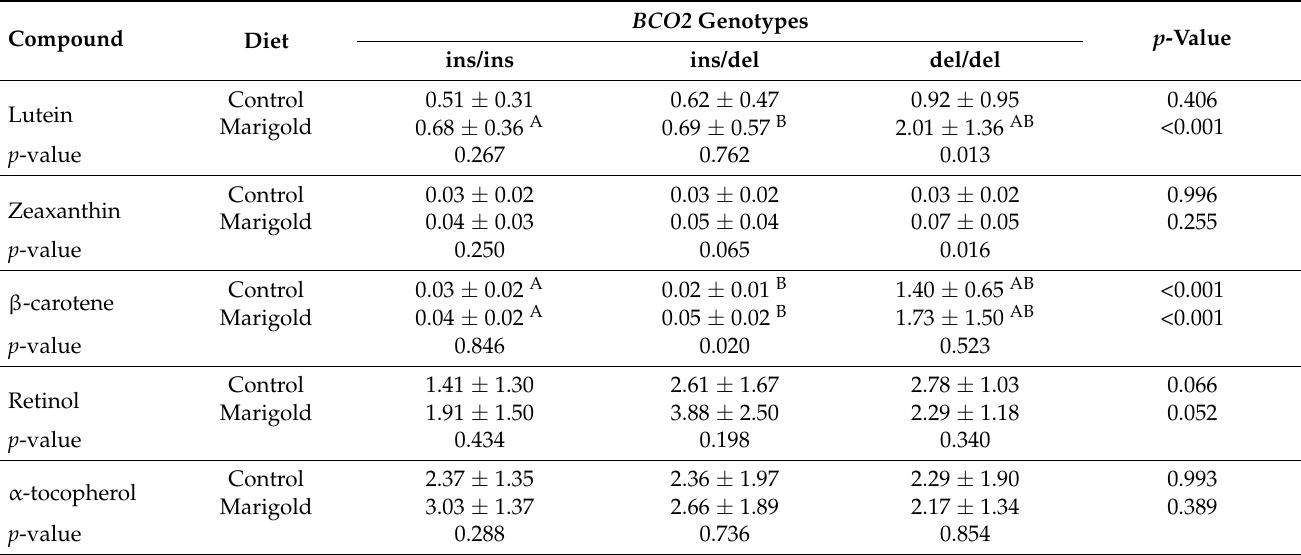
Table 2. Content of selected compounds in the blood serum ( µ g/g) of rabbits (mean ± SD).